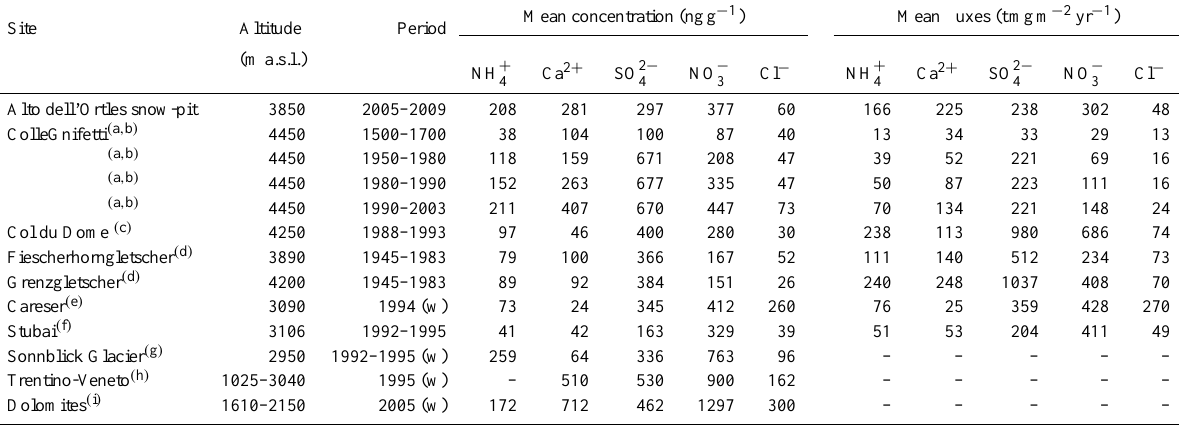
Table 3. Mean concentration and fluxes of major ions in snow and ice samples in different Alpine sites: glacier Alto dell’Ortles snow pit (mean accumulation ∼ 800mm w.e.), Colle Gnifetti firn/ice core (Monte Rosa; 330mm w.e.), Col du Dome firn/ice core (Mont Blanc, 2450mmw.e.yr − 1 ), Fiesherhorngletscher firn/ice core (Bernese Alps; 1400mmw.e.yr − 1 ), Grenzgletscher firn/ice core (Monte Rosa; 2700mmw.e.yr − 1 ), Careser (Ortles-Cevedale, Italian Eastern Alps; accumulation 1040mmw.e.yr − 1 ), Stubai (Austrian Tyrolean Alps; 1250mmw.e.yr − 1 ), Sonnblick (Austrian Tyrolean Alps), Dolomites (Eastern Italian Alps). The “w” associated with the period indi- cates that only winter snow was